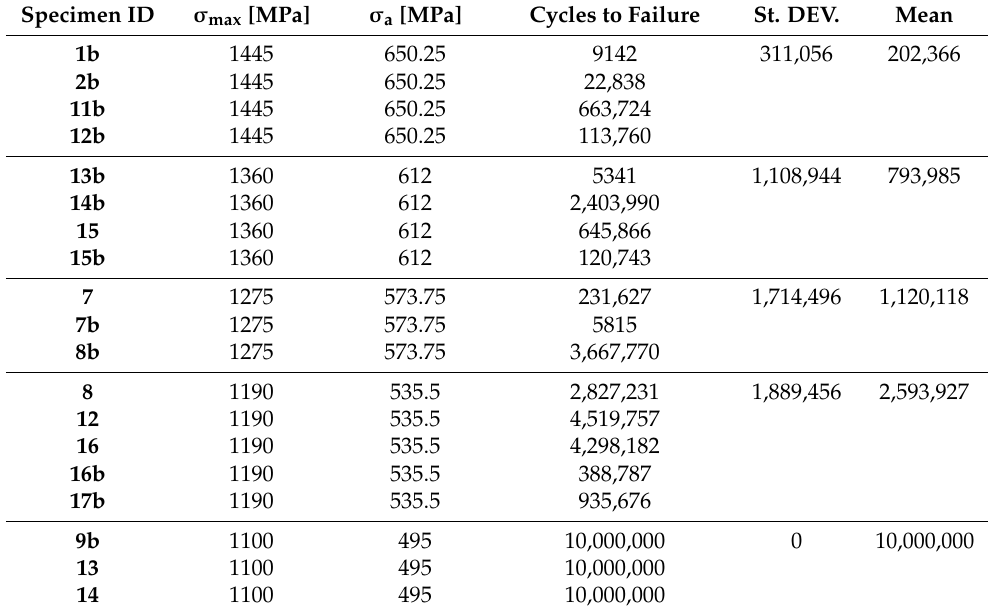
Table 2. Fatigue test